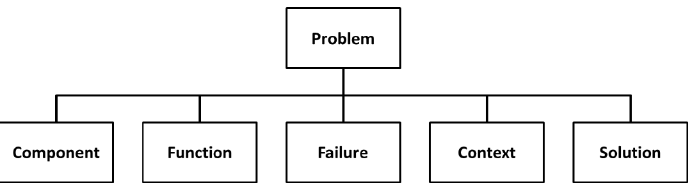
Figure 2. Manufacturing Problem Solving (MPS) top-level Ontology.